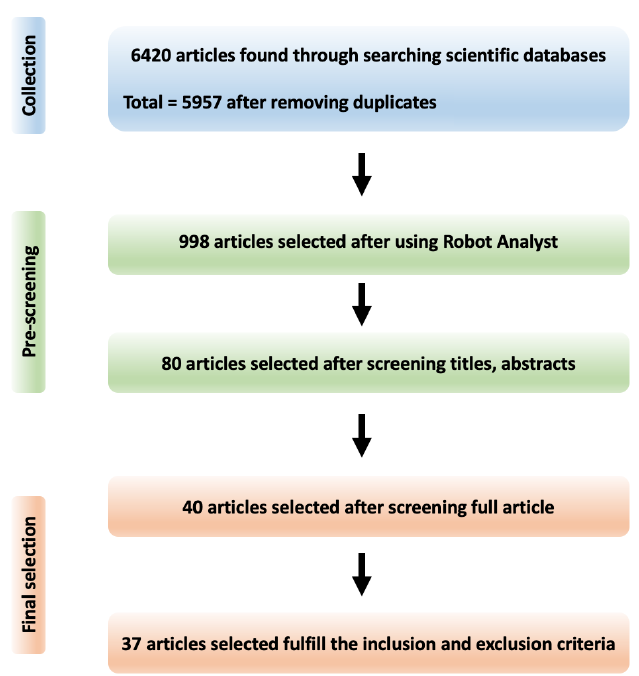
Figure 1. Overview of article selection process used in this narrative literature review.